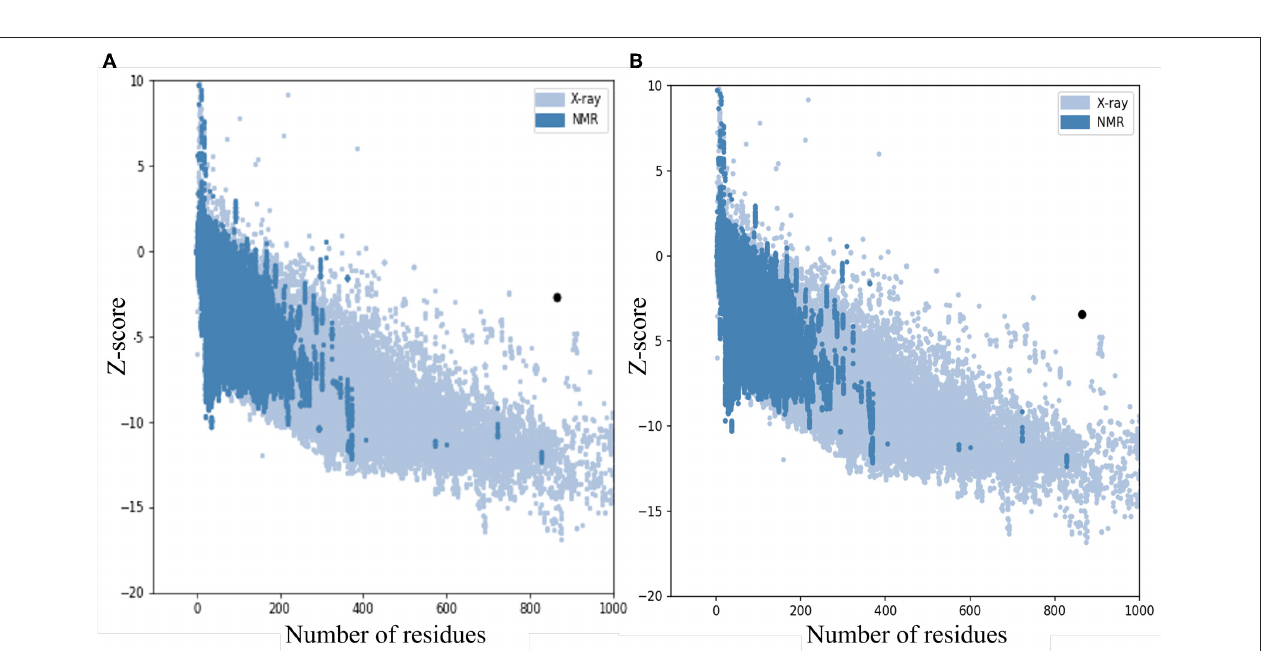
FIGURE 4 | Ramachandran plots to initiate and refine the 3D structure of the vaccine construct illustrated using the SWISS-MODEL/Structure Assessment. (A) Shows the Ramachandran plot of initiate model, (B) shows the Ramachandran plot of refining the model.